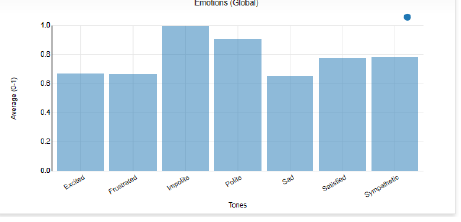
Figure 24. Volunteer Tones for a counsellor